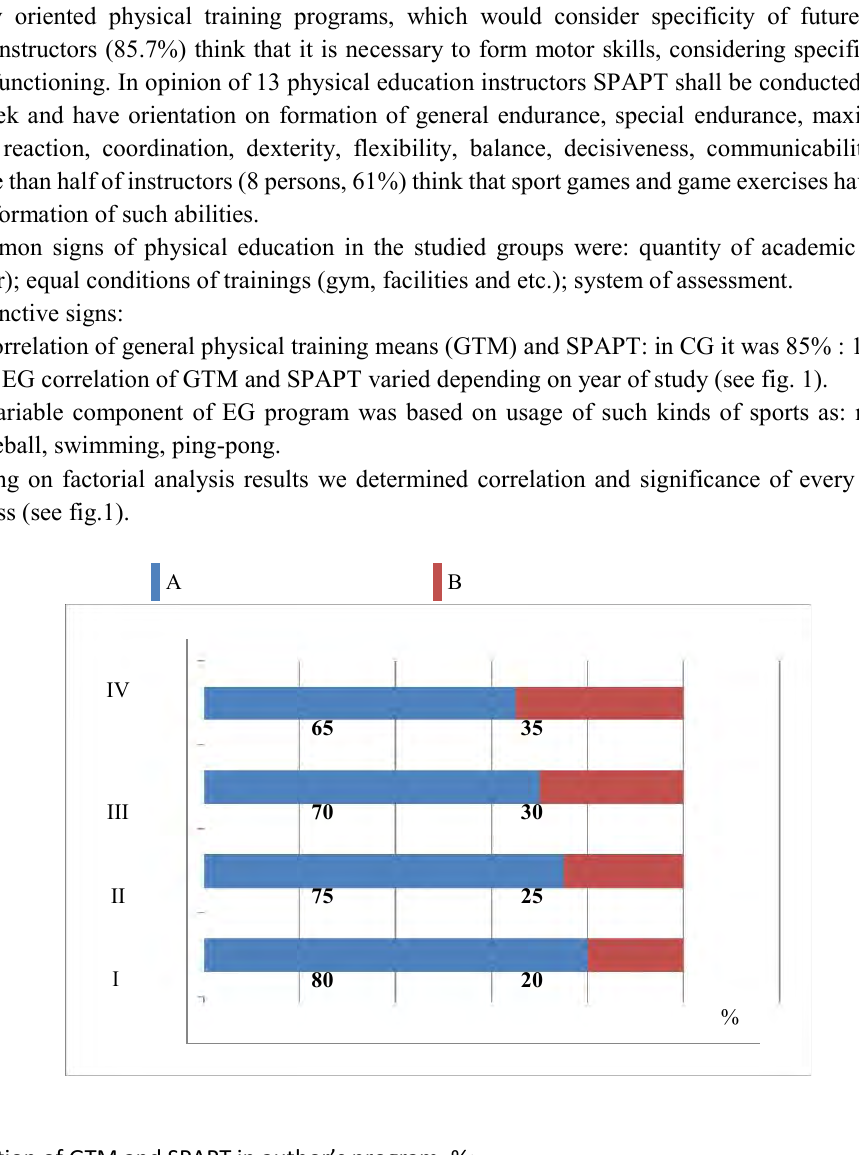
Fig.1. Correlation of GTM and SPAPT in author’s program,